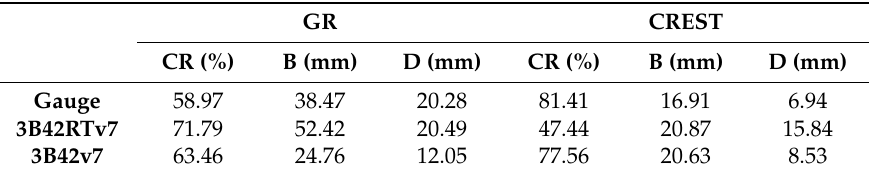
Table 4. Statistical indexes for interval